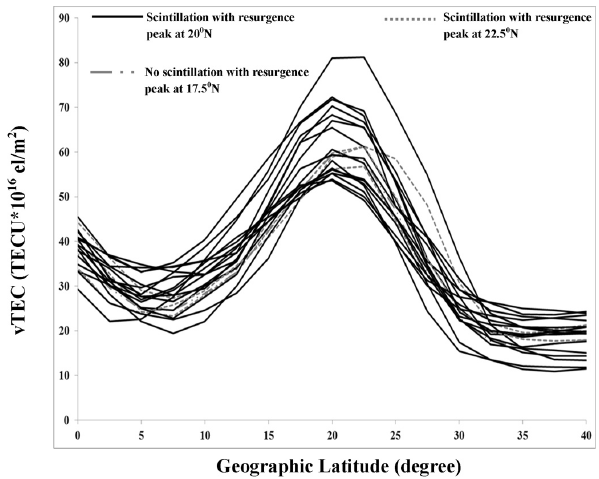
Fig. 12. Mass plot of latitudinal distribution of VTEC, estimated at 85 ◦ E longitude, around 19:00IST ( = UT + 05:30h), showing the evening anomaly peaks predominantly situated around 20 ◦ N (geo- graphic) on most of the days of post-sunset VHF scintillations. For some scintillation days it is around 22.5 ◦ N, while the peak is seen to be around 17.5 ◦ N for no scintillation